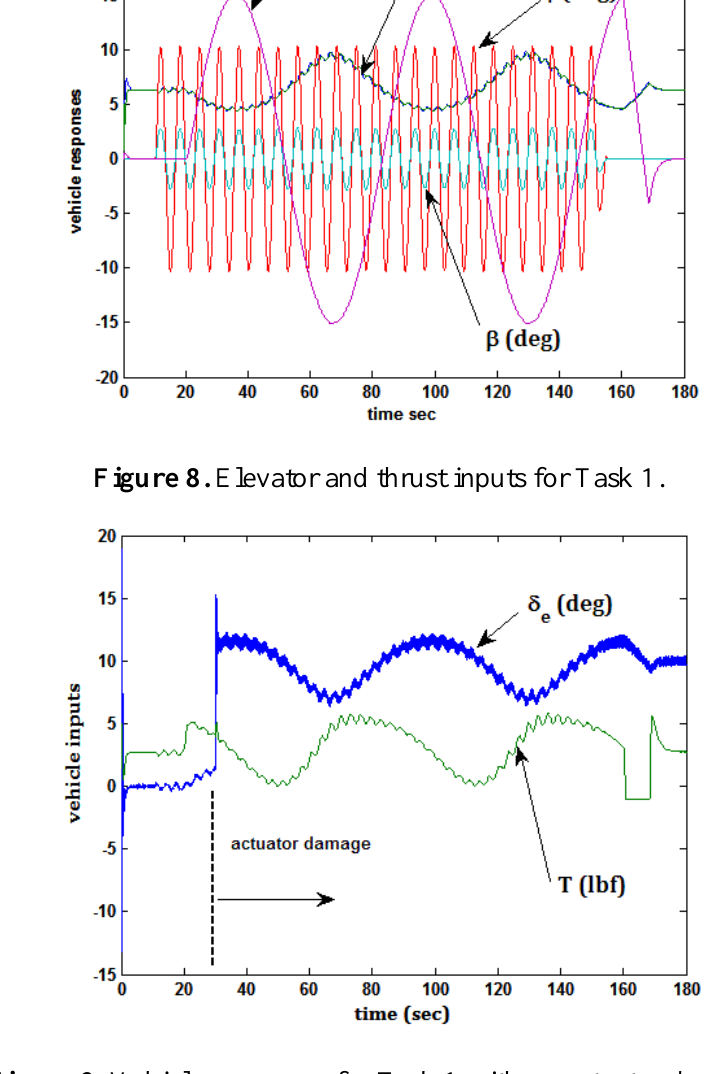
Figure 9. Vehicle responses for Task 1 with no actuator